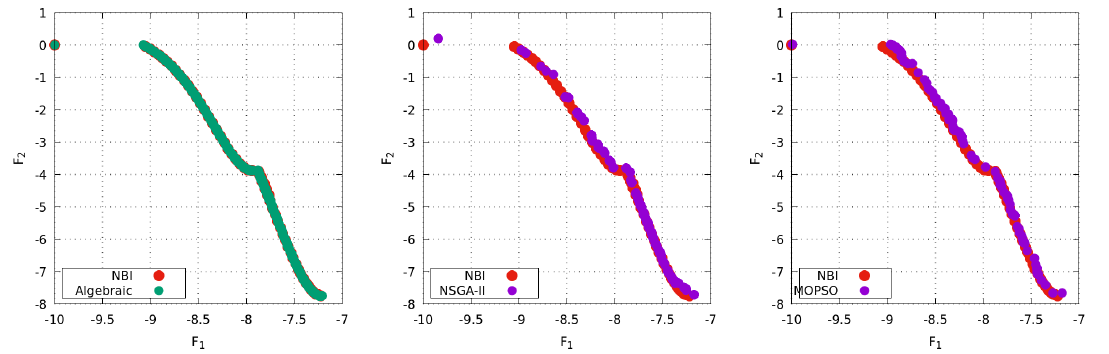
Figure 2. Pareto front approximation obtained by using the three methodologies sequentially, in comparison with a different optimization algorithm (NSGA-II and MOPSO). In the first picture at the left, NBI is compared with the true Pareto front. The other two pictures show the comparison of the results obtained by NBI versus NSGA-II and MOPSO